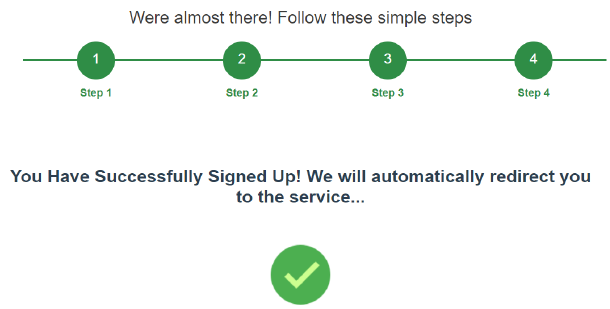
Figure 10. Completion of the interaction with LA .